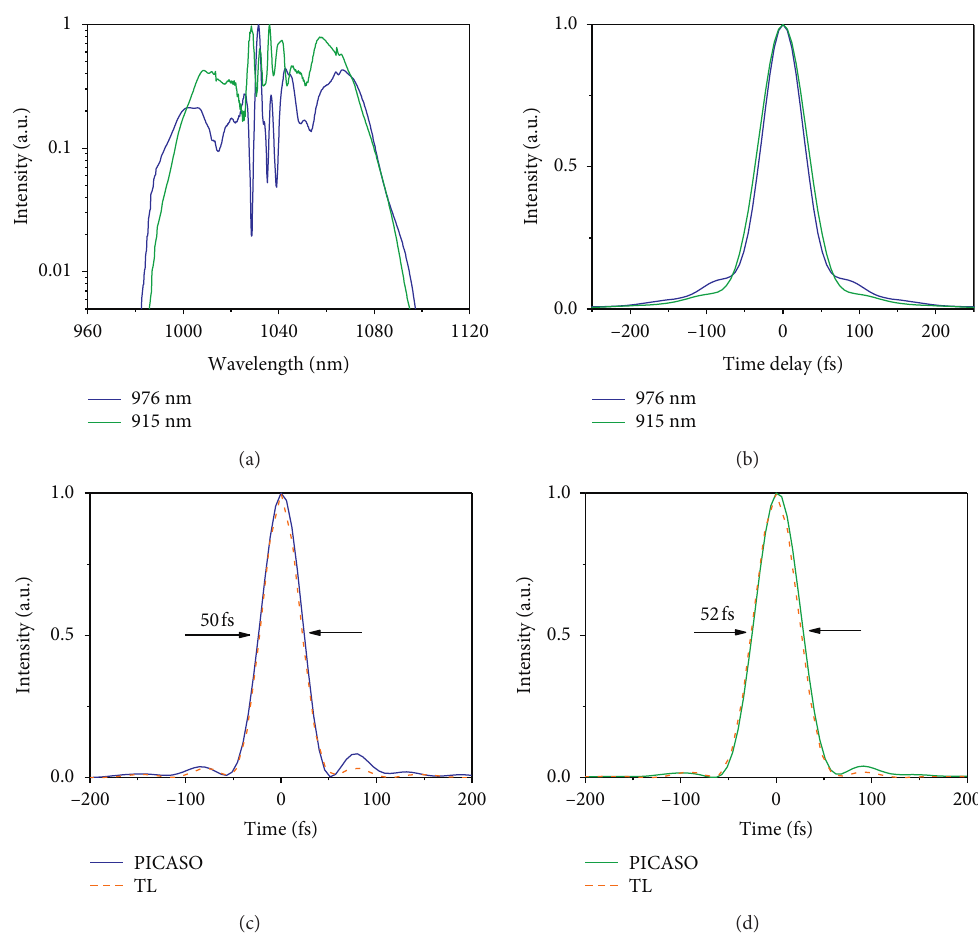
Figure 2: (a) Measured spectrums and (b) AC traces of the output amplified pulses under a pump wavelength of 976 nm (blue solid curve) and 915nm (green solid curve). PICASO-retrieved (solid curves) and transform-limited (dashed curves) pulse under a pump wavelength of (c) 976nm and (d) 915nm.